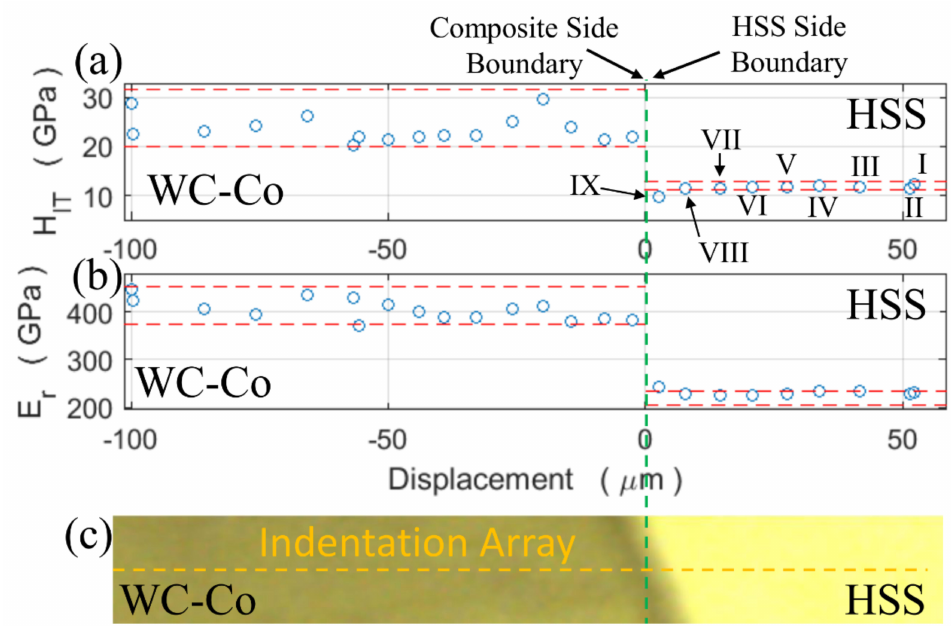
Figure 19. Indentation hardness ( a ) and reduced modulus ( b ) vs. displacement along the nIIT array across a narrow (less than 10 µ m) transitional layer. The red dashed lines show the ranges of indentation hardness and reduced modulus characteristics of the base materials, ( c ) is the optical microscopy image taken from the positioning system of the nano-indenter machine. The Roman numerals indicate the nine nano-indentation imprints on the HSS side, according to Figure 17. The green dashed line indicates the HSS / WC-Co interface. The green dashed lines indicate the composite and the HSS side boundaries of the transitional layer. The thickness of the transitional layer is less than the distance between two nano-indentations, thus both its boundaries lie on the same dashed